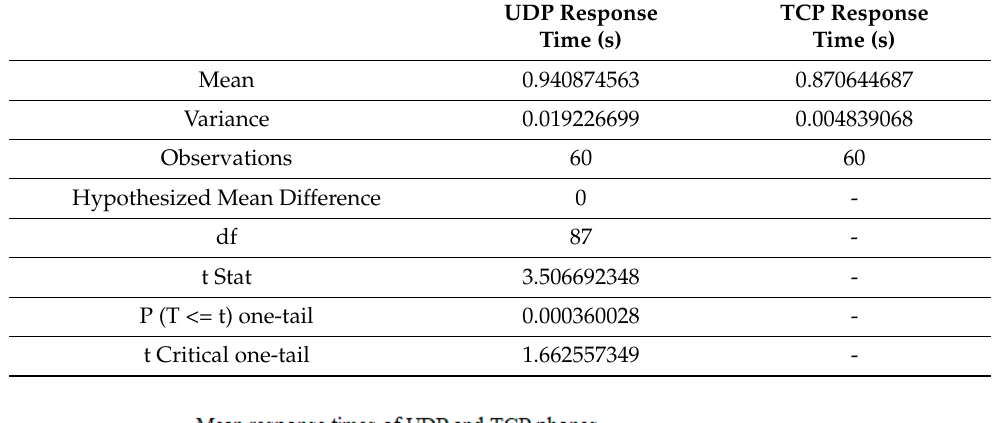
Table 6. Results, Experiment 3.